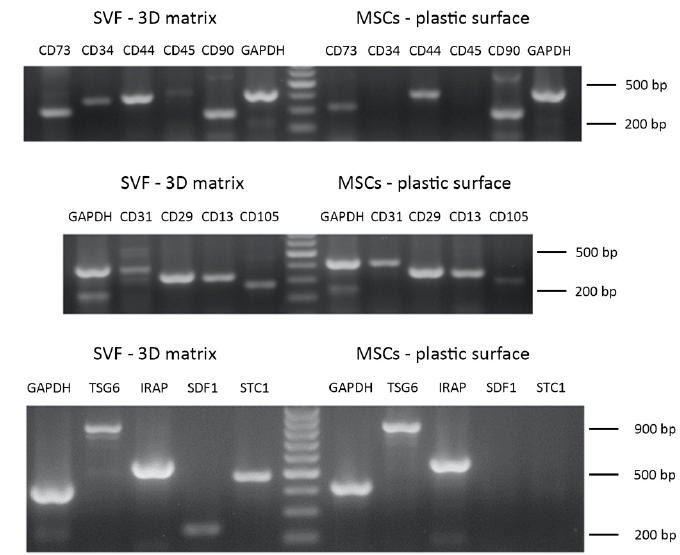
Figure 11 . Phenotypic characterization of ADMSCs and adipose tissue-derived SVF by RT-PCR. Upper and middle panel: gene expression analysis for MSCs markers. Lower panel: expression analysis of genes involved in anti-inflammatory and immunomodulatory features of MSCs. Table 4 . Phenotypic characterization of ADMSCs and adipose tissue-derived SVF by RT-PCR.